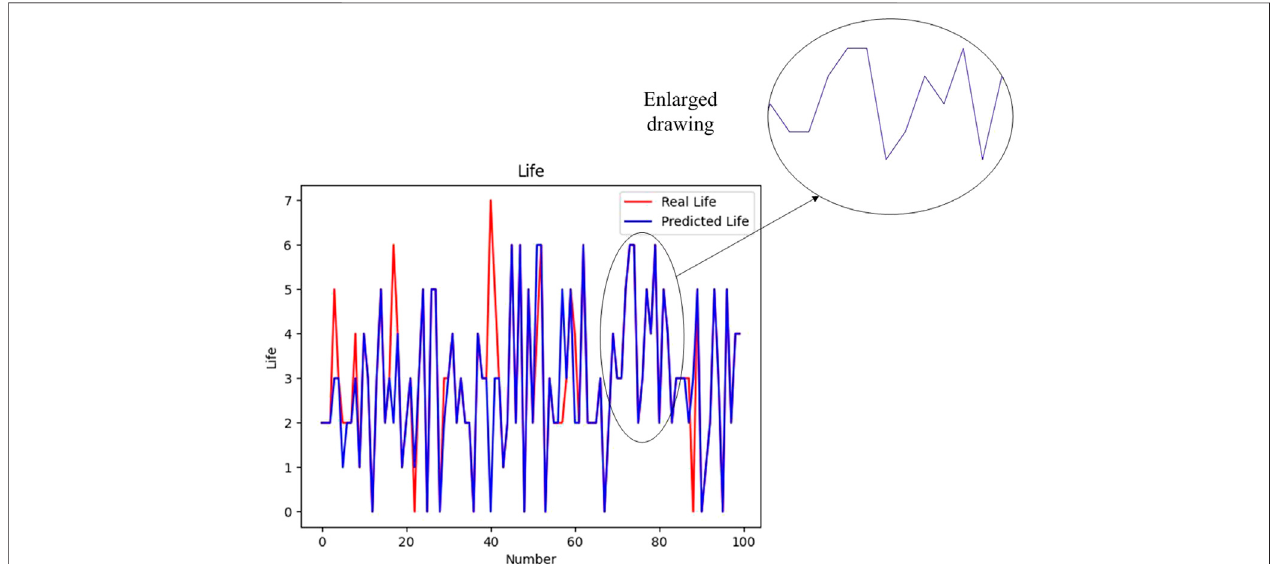
FIGURE 5 | Prediction